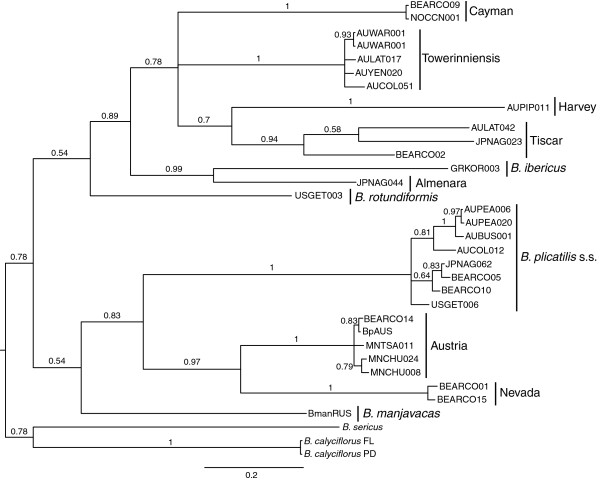
Bayesian trees of coxI coding sequences. Posterior probabilities are shown along the branches. Names at the tip of each branch designate isolates. Phylotype and major clade designations are shown to the right.